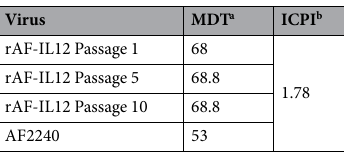
Table 2. Viral titers and chicken pathogenecity. a Mean death time (MDT) in eggs measured in hours. Velogenic strains, < 60 h; mesogenic strains, 60 to 90 h; lentogenic strains, > 90 h. b Pathogenicity of NDV in 1-day-old pathogen-free chicks measured by ICPI. ICPI scale, 0 to